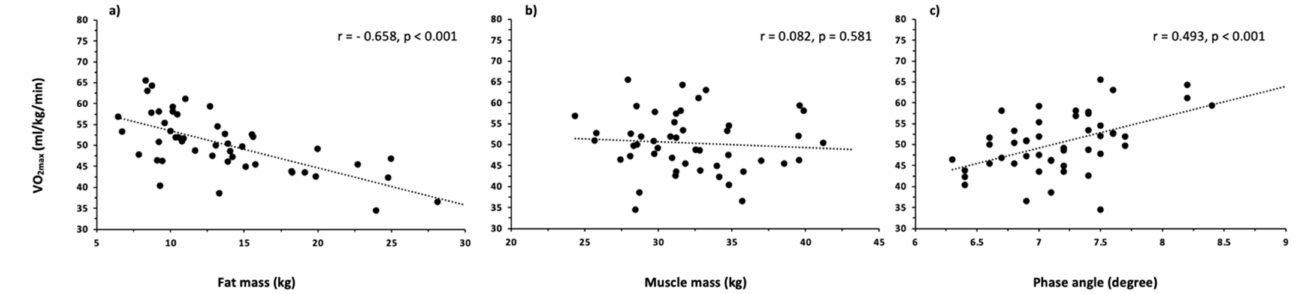
Figure 4. Correlation between fat mass (panel ( a )) and muscle mass (panel ( b )) phase angle (panel ( c )) with VO 2max in the futsal